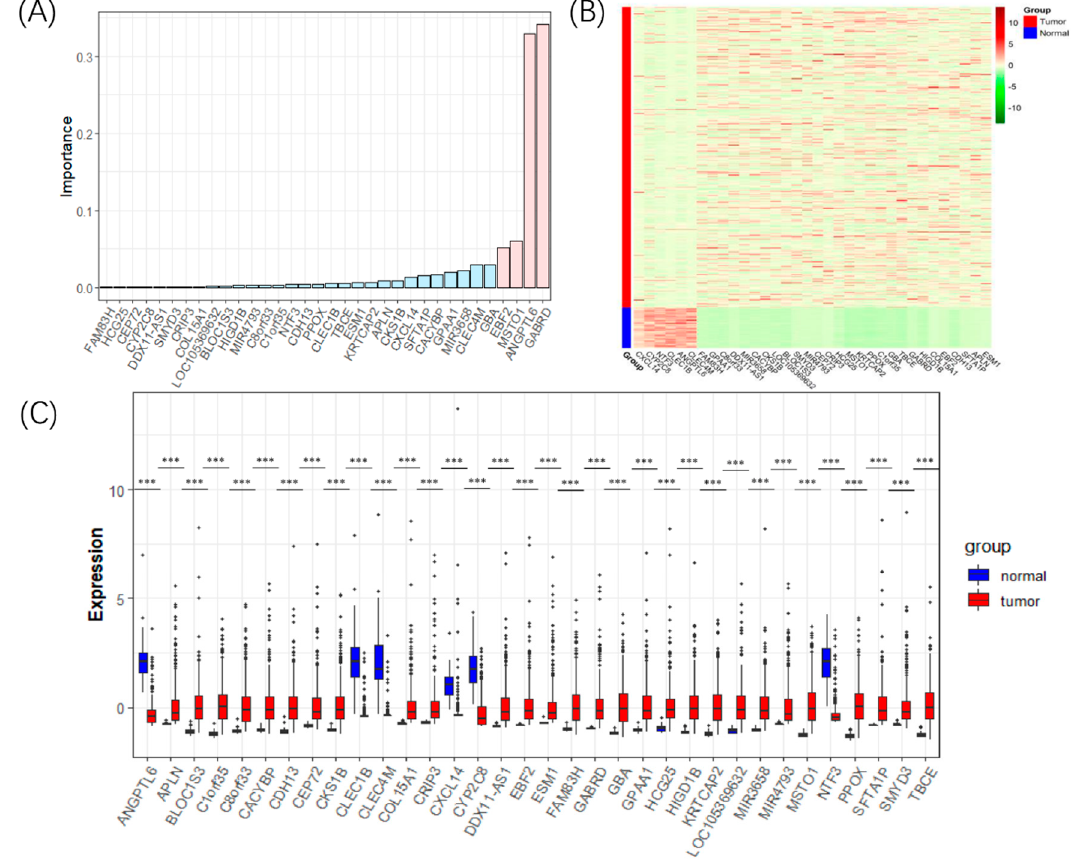
Figure 2. The detected 34 DEGs for LIHC. ( A ) The bar plot of the importance values of the 34 DEGs, in which the genes’ importance scores above 0.05 were marked pink, and the rest were marked sky blue. ( B ) The heat map showing the expression level of the 34 DEGs in the tumors and normal samples. ( C ) Boxplots comparing the expression level of the 34 DEGs in the tumors and normal samples. Three stars (***) marks DEGs whose p -value < 0.001.